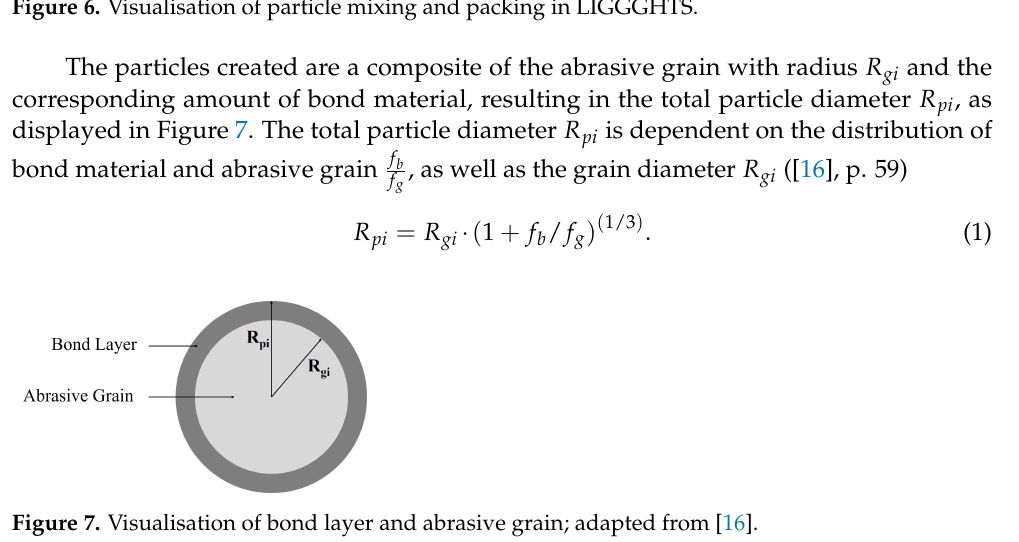
Figure 6. Visualisation of particle mixing and packing in LIGGGHTS.